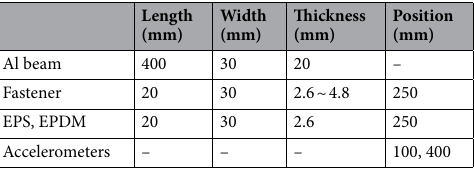
Table 1. Geometric parameters of the cantilever beam experimental setup.